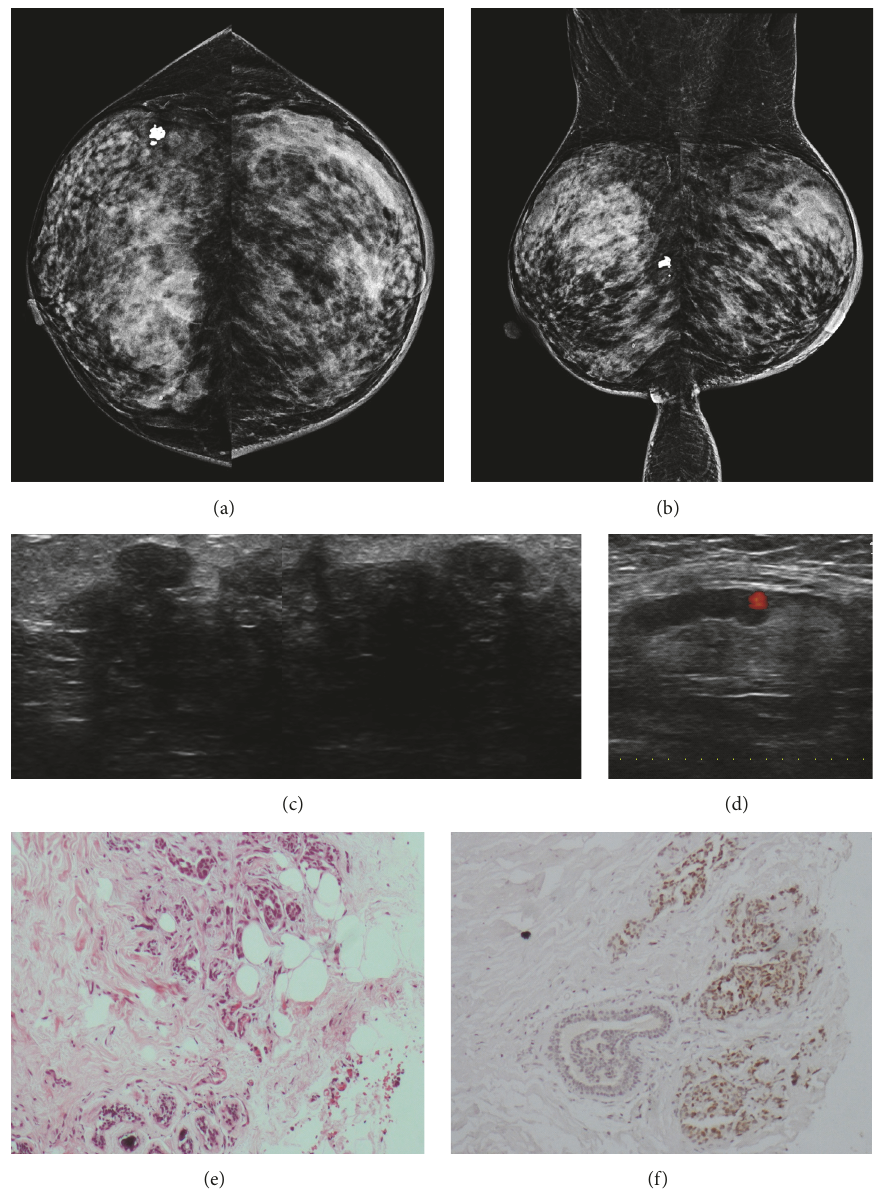
Figure 4: Case 4. A 56-year-old woman diagnosed with ovarian adenocarcinoma. One month after diagnosis, the patient presented with palpable axillary adenopathy. Mammogram showed dermal and trabecular thickening in the left breast, with diffusely increased density of the mammary tissue ( a–b ). On ultrasound, an irregular hypoechoic mass with indistinct margins was revealed ( c ). An axillary lymph node withcorticalindentationwasalsoobservedbyultrasound( d ).HEstainingandimmunohistochemistryanalysisofthemetastases.HEstaining revealed the malignant cells in the breast tumor ( e ), and the immunohistochemistry analysis indicated that the cells were positive for PAX8 ( f